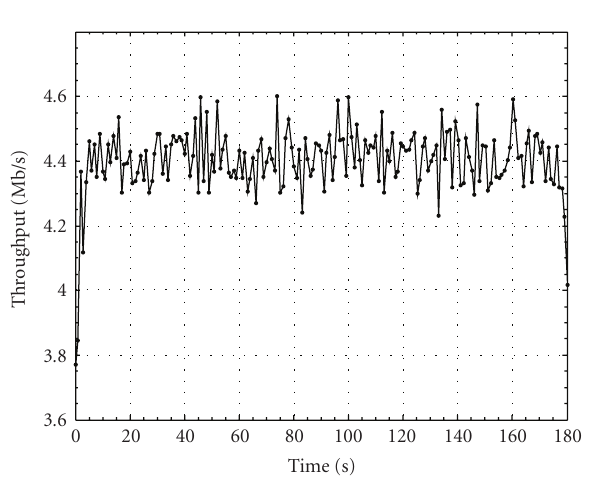
Figure 6: Experimental test bed.